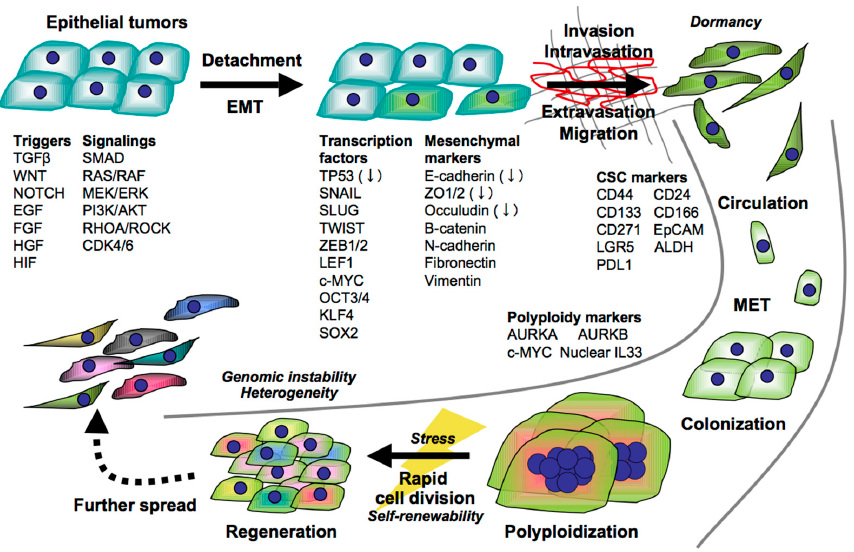
Figure 1. Tumor evolutional transformation through epithelial – mesenchymal transition (EMT), the reverse process of EMT (mesenchymal-to-epithelial transition, MET), and polyploidization toward successful metastasis. The molecules designated are representative molecules that are induced and enhanced in the tumor cells, except decreased molecules with a down arrow. TGF β stands out as a master regulator of cancer EMT, and the canonical TGF β -SMAD pathway plays a key role in the EMT program in cooperation with other signaling pathways, such as PI3K/AKT, ERK/MAPK, PAR6, ras homolog family member A (RHOA), and Rho-associated, coiled-coil containing protein kinase (ROCK) [16,17]. TGF β activates SMAD2/3 and forms complexes with SMAD4, which regulate the transcription of EMT-related target genes, resulting in the repression of epithelial marker gene